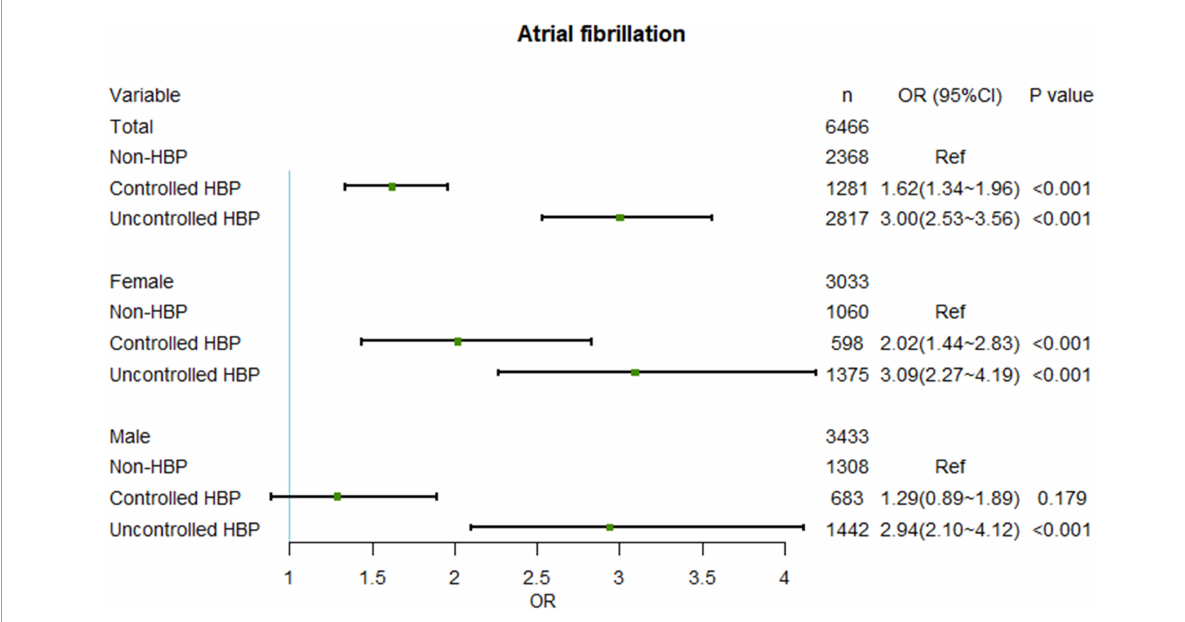
FIGURE4 Relationship between AF and different BP controlled group after PSM. No interaction effects existed between sex and BP controlled groups. AF, atrial fibrillation; OR, odd ratio; BP, blood pressure; PSM, propensity score